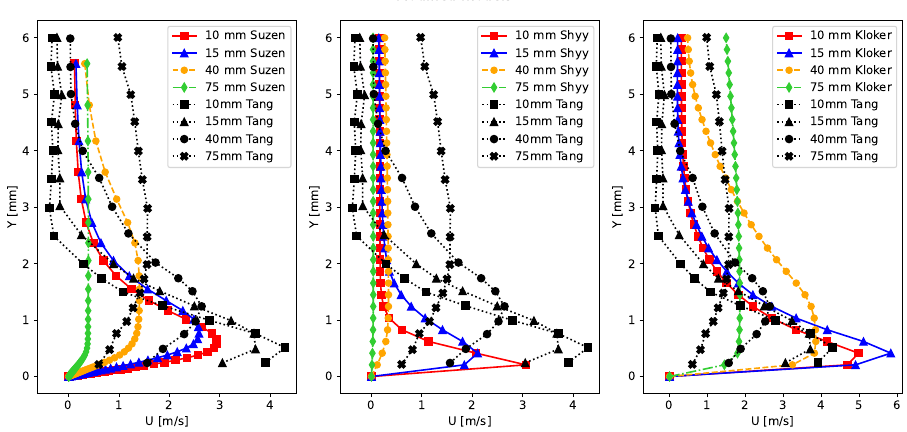
Figure 12. Velocity profiles for the modified models (case 2 setup) at 18 kV and 2